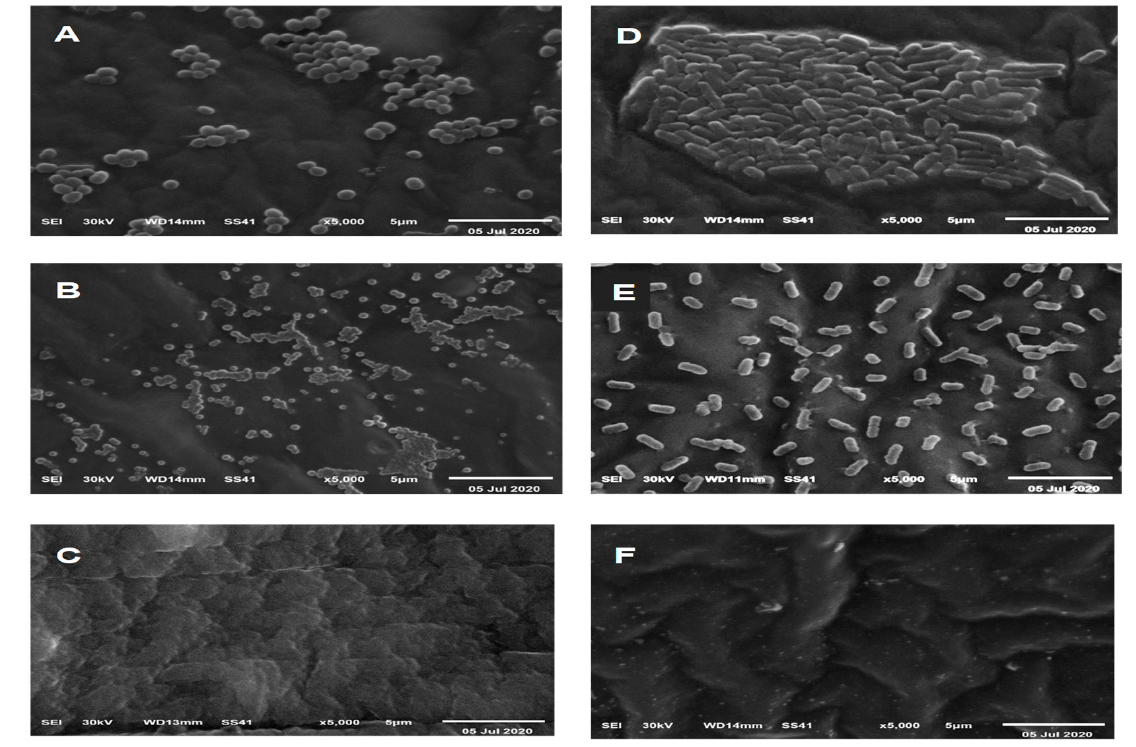
Figure 7. Electron micrographs of the bacterial colonisation of control catheters ( A , D ), catheters varnished with mastic ( B , E ), and catheters varnished with mastic and AgNPs ( C , F ) after 48 h impreg- nation in nutrient inoculated with 10 5 CFU mL − 1 of Staph. aureus ( A – C ) and Kl. pneumoniae ( D – F ).